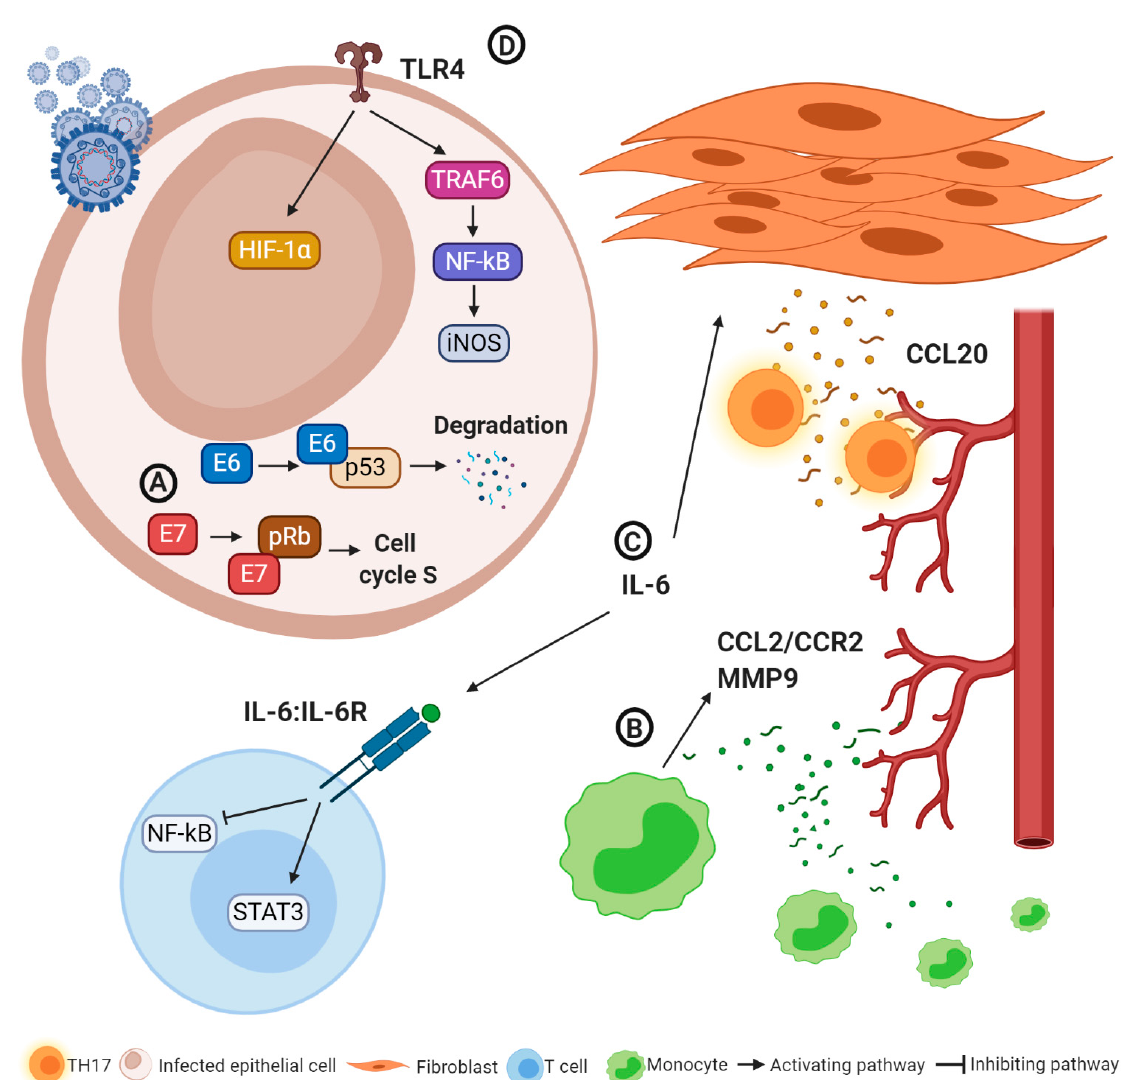
Figure 2. Oncogenic and immune escape mechanisms in human papilloma virus (HPV)-related tumors. ( A ) E6 and E7 proteins contribute to averting apoptosis of infected cells and promoting cell proliferation, paving the way for neoplastic transformation. ( B ) IL-6 reduces the anti-tumoral activity of T lymphocytes and promotes CCL20 expression by cancer- associated fibroblasts and T helper 17 recruitment, also promoting cancer progression. ( C ) CCL2/CCR2 and MMP-9 production lead to monocyte infiltration and angiogenesis. ( D ) TLR4 activation promotes cancer progression through HIF-1 α induction and nitric oxygen synthesis. Abbreviations: CCL2 and 20: C-C motif chemokine ligand 2 and 20; CCR2: C-C chemokine receptor type 2; HIF-1 α : hypoxia-inducible factor-1 α ; IL 6: interleukin 6; IL6R: interleukin 6 receptor; iNOS: inducible nitric oxygen synthase; MMP-9 matrix-metalloproteinase 9; NFkB: nuclear factor kappa-light-chain-enhancer